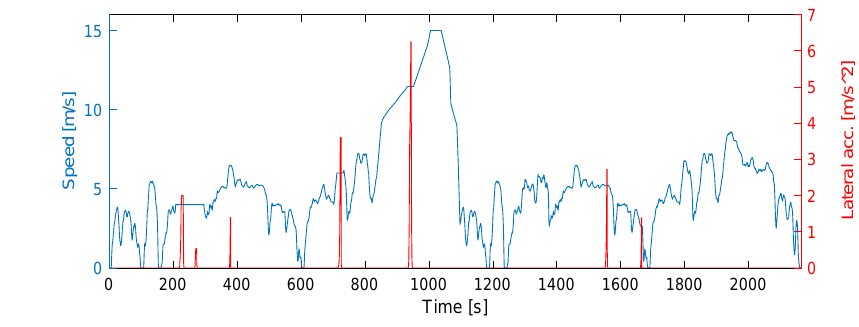
Figure 3 – Created drive cycle for the EMS